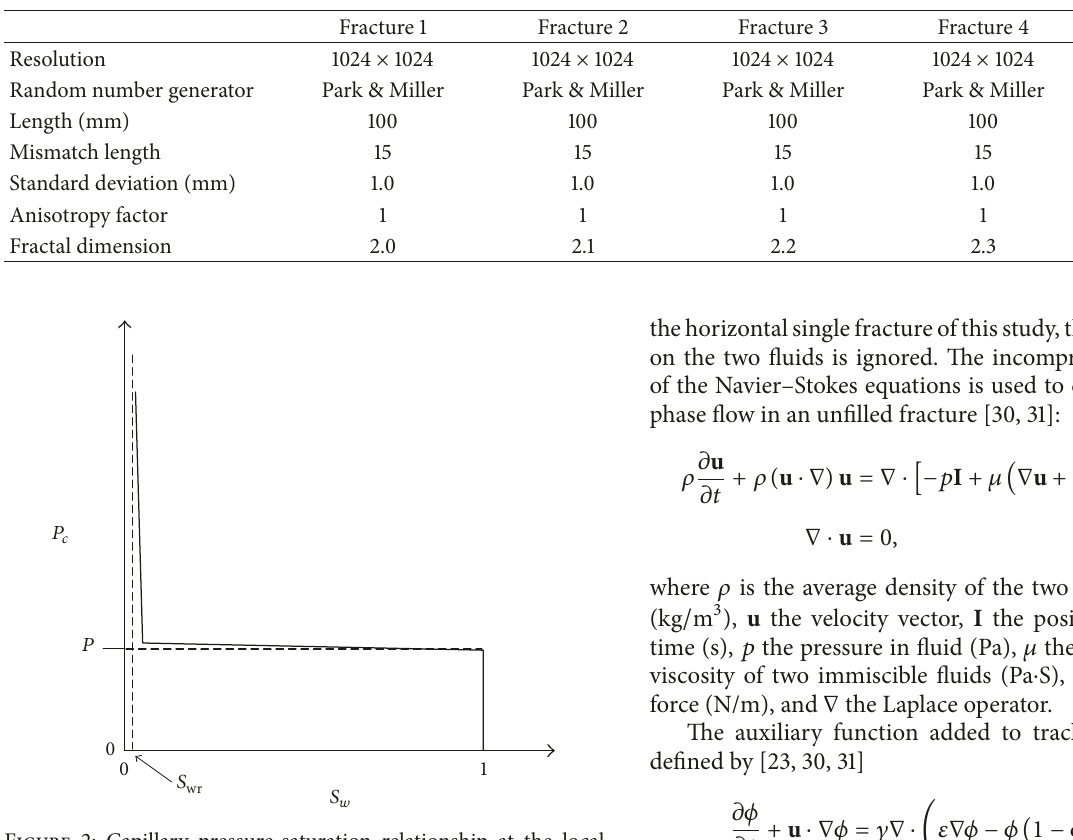
Table 1: Input parameters of SynFrac for generation of fractures with various roughness.